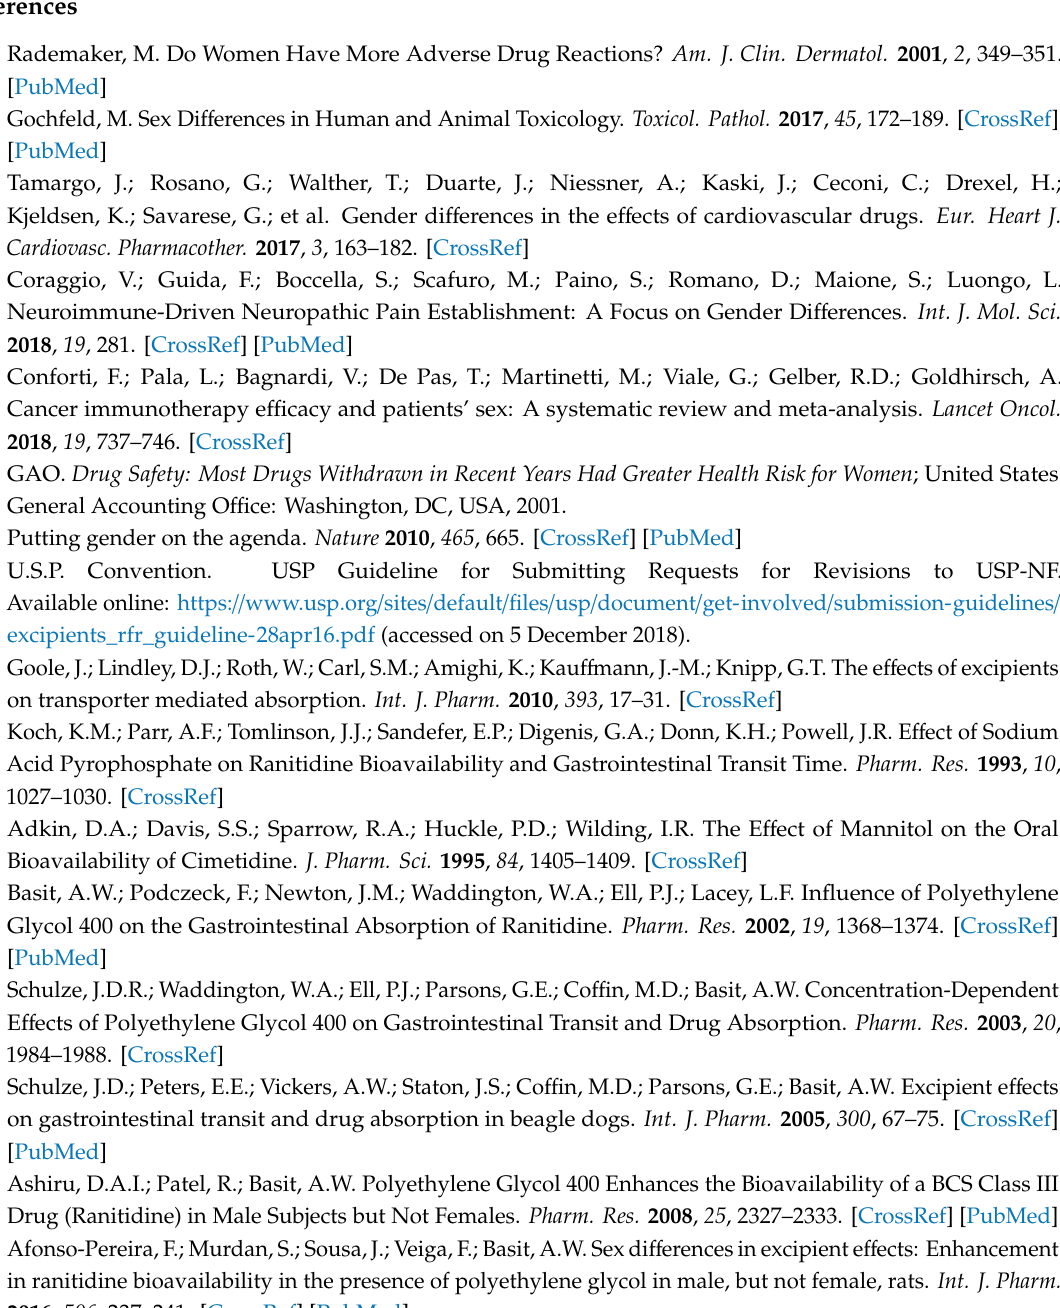
Figure S1: Percentage changes in mdr1b mRNA expression in the presence of excipients in male and female Wistar rats (mean ± SD, n =